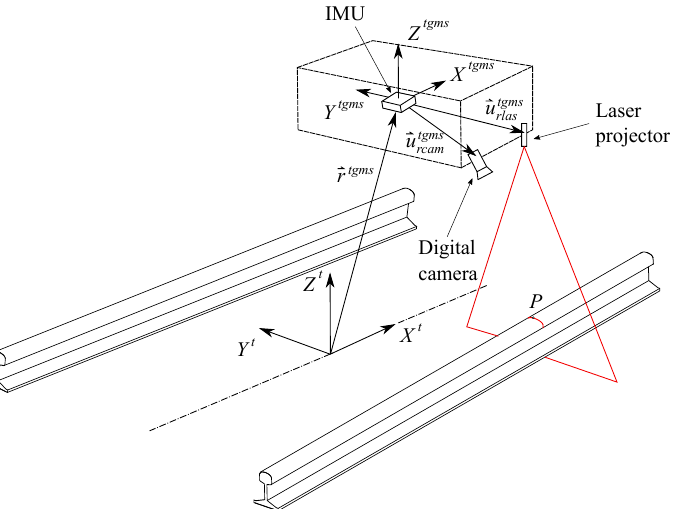
Figure 1. Kinematics of the Track Geometry Measuring System (TGMS) installed in a vehicle moving along the